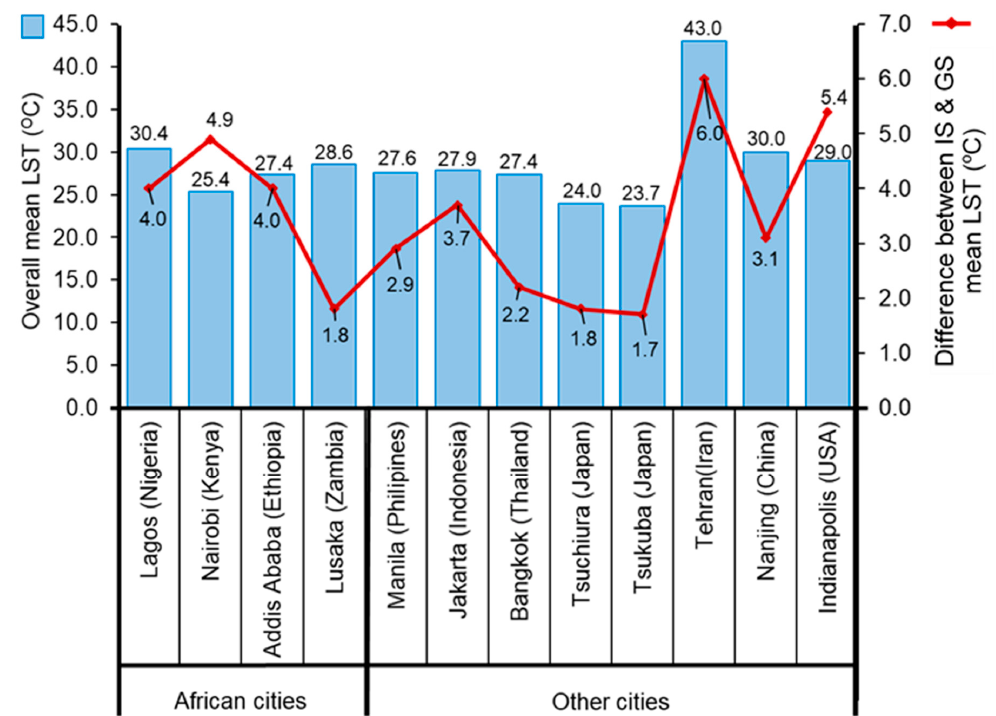
Figure 9. Overall mean LST and differences between the mean LST of impervious surfaces (IS) and green spaces (GS) in African and other cities [8,17,19,26,62]. green spaces (GS) in African and other cities